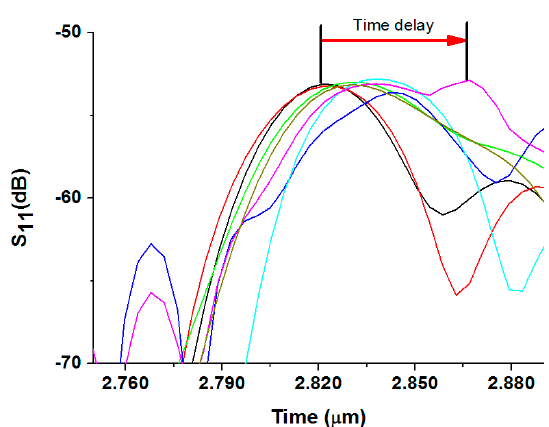
Figure 11. Reflection peak was shifted in the time domain as target biomolecules was selectively attached, and thus the propagating velocity of the acoustic wave was slowed mainly due to mass loading effect.